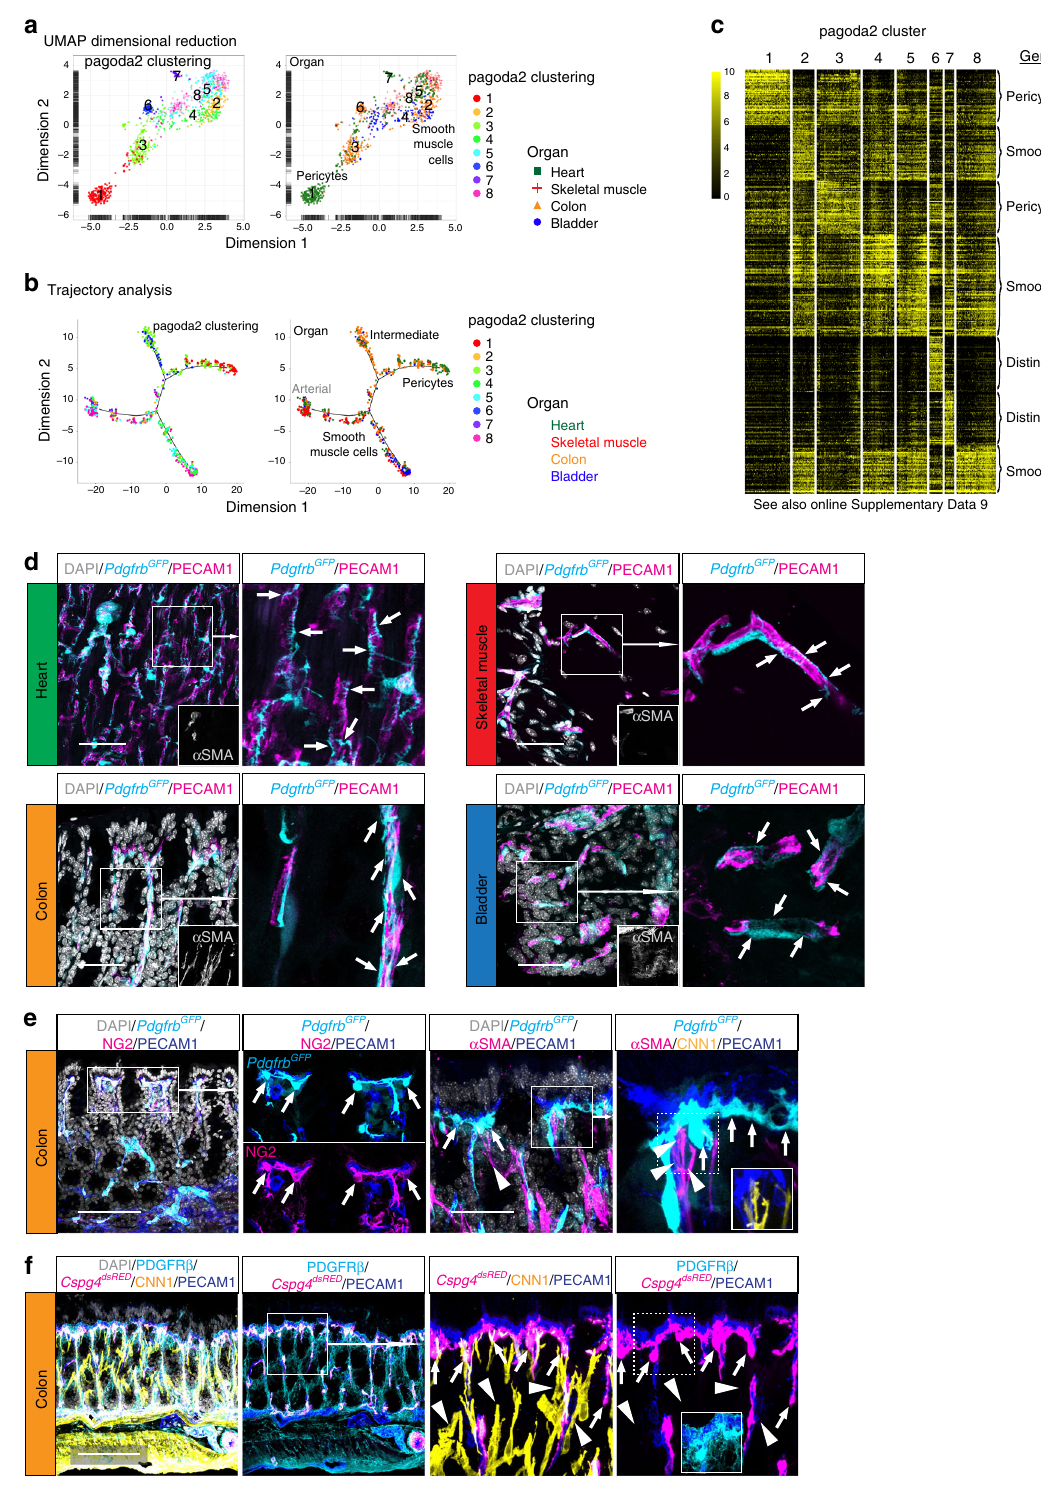
Fig. 7 Mural cell organotypicity. a UMAP visualization of the mural cell dataset, color coded and annotated for pagoda2 clustering (left) or color coded for organ of origin and annotated for pagoda2 clustering (right). b Trajectory analysis plots of the mural dataset color coded for pagoda2 clusters (left) or organ of origin (right). c Expression heat map (black, low; yellow, high) of cluster enriched genes (see also Online Supplementary Data 9). d Samples from all four organs from the Pdgfrb GFP reporter line, stained with immuno fl uorescence for α SMA and PECAM1. Arrows highlight pericytes and their morphological distribution at the organ-speci fi c capillaries. Scale bars: 50 µ m. e Immuno fl uorescence staining of colon samples from Pdgfrb GFP reporter line for NG2 ( Cspg4 ) and PECAM1 (left panel), or α SMA, CNN1 and PECAM1 (right panel). f Immuno fl uorescence staining of colon samples from Cspg4 dsRED reporter line for PDGFR β , CNN1 and PECAM1. Arrows highlight colon pericytes located at the subepithelial capillary loop, arrowheads indicate α SMA + CNN1 + , but Cspg4 (NG2) − interstitial SMC. Scale bars: e 100 µ m (left panel f ), 50 µ m ( e right